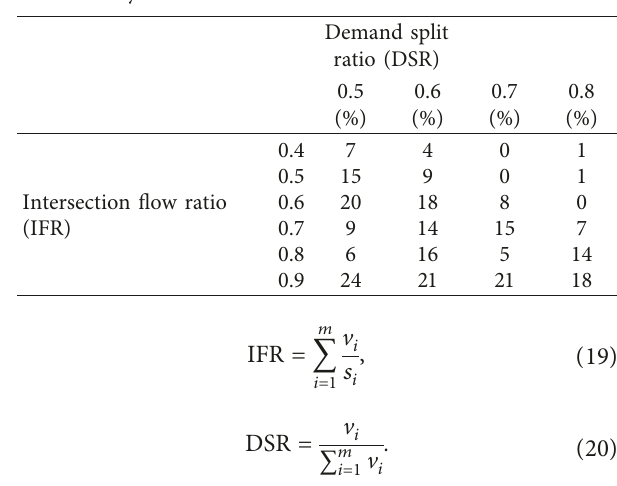
Table 11: Variation of percentage reduction in average intersection control delay.